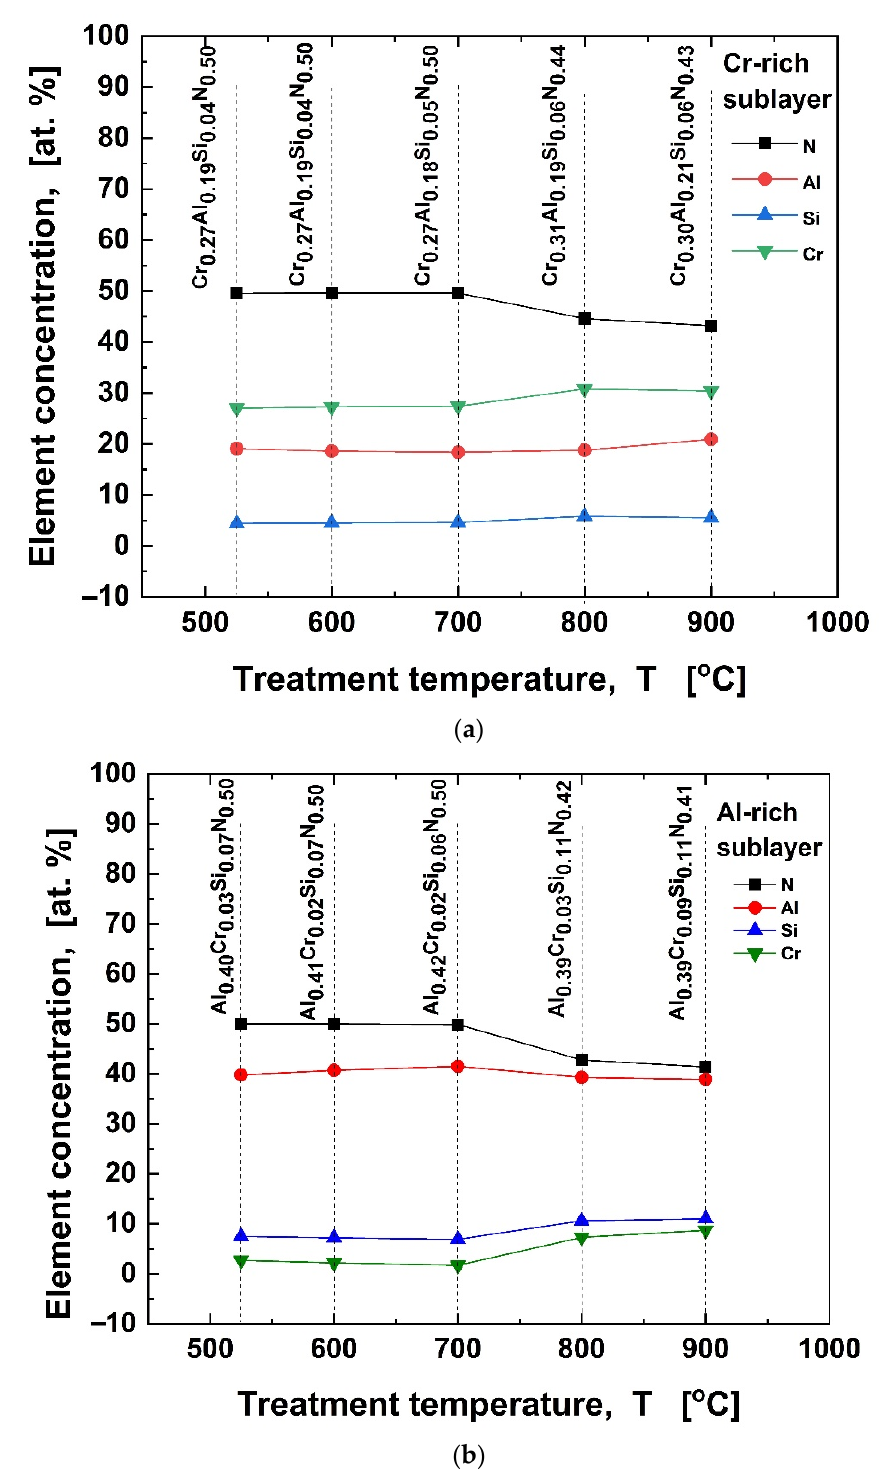
Figure 6. Dependence of element composition of CrAlSiN-AlSiN modulated coating on treatment temperature: ( a ) Cr-rich region; ( b ) Al-rich region.